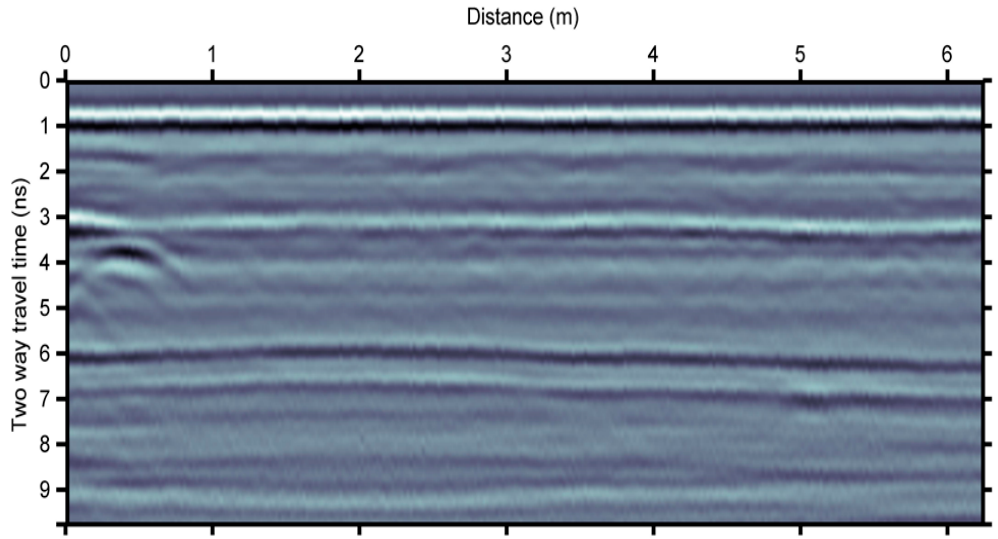
Figure 9. The GPR section after the application of a band-pass filter to the section represented in Figure 6 and the application of the IAD gain.